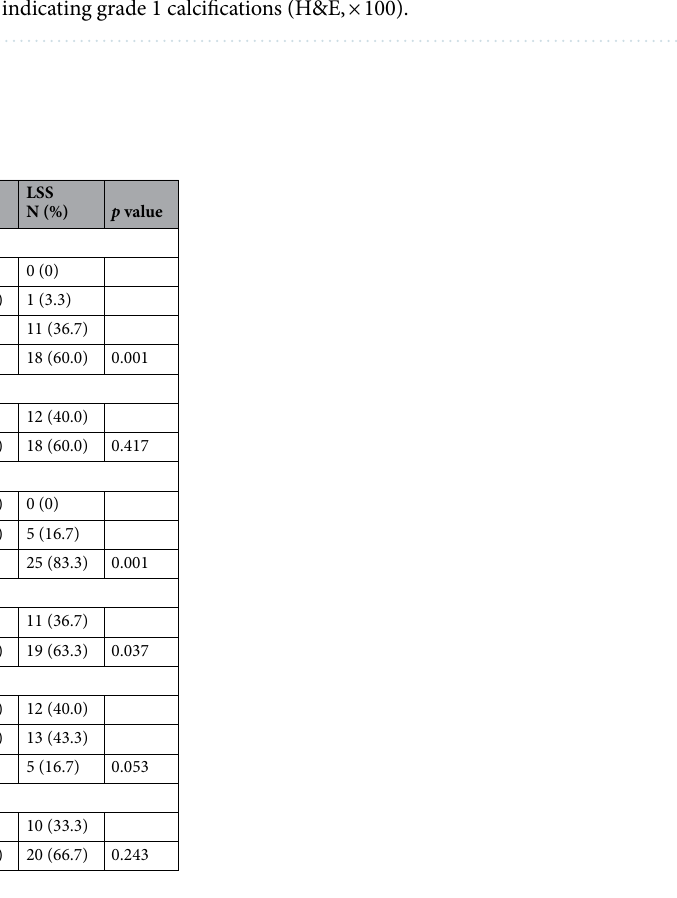
Table 4. The LF histopathological